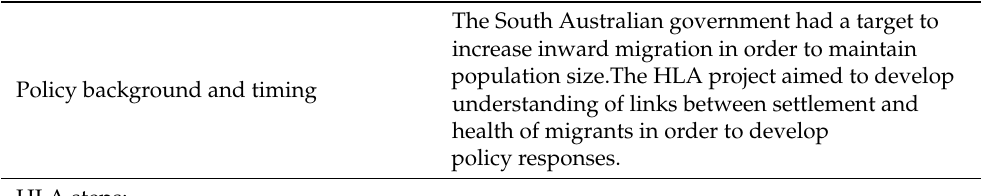
Policy background and